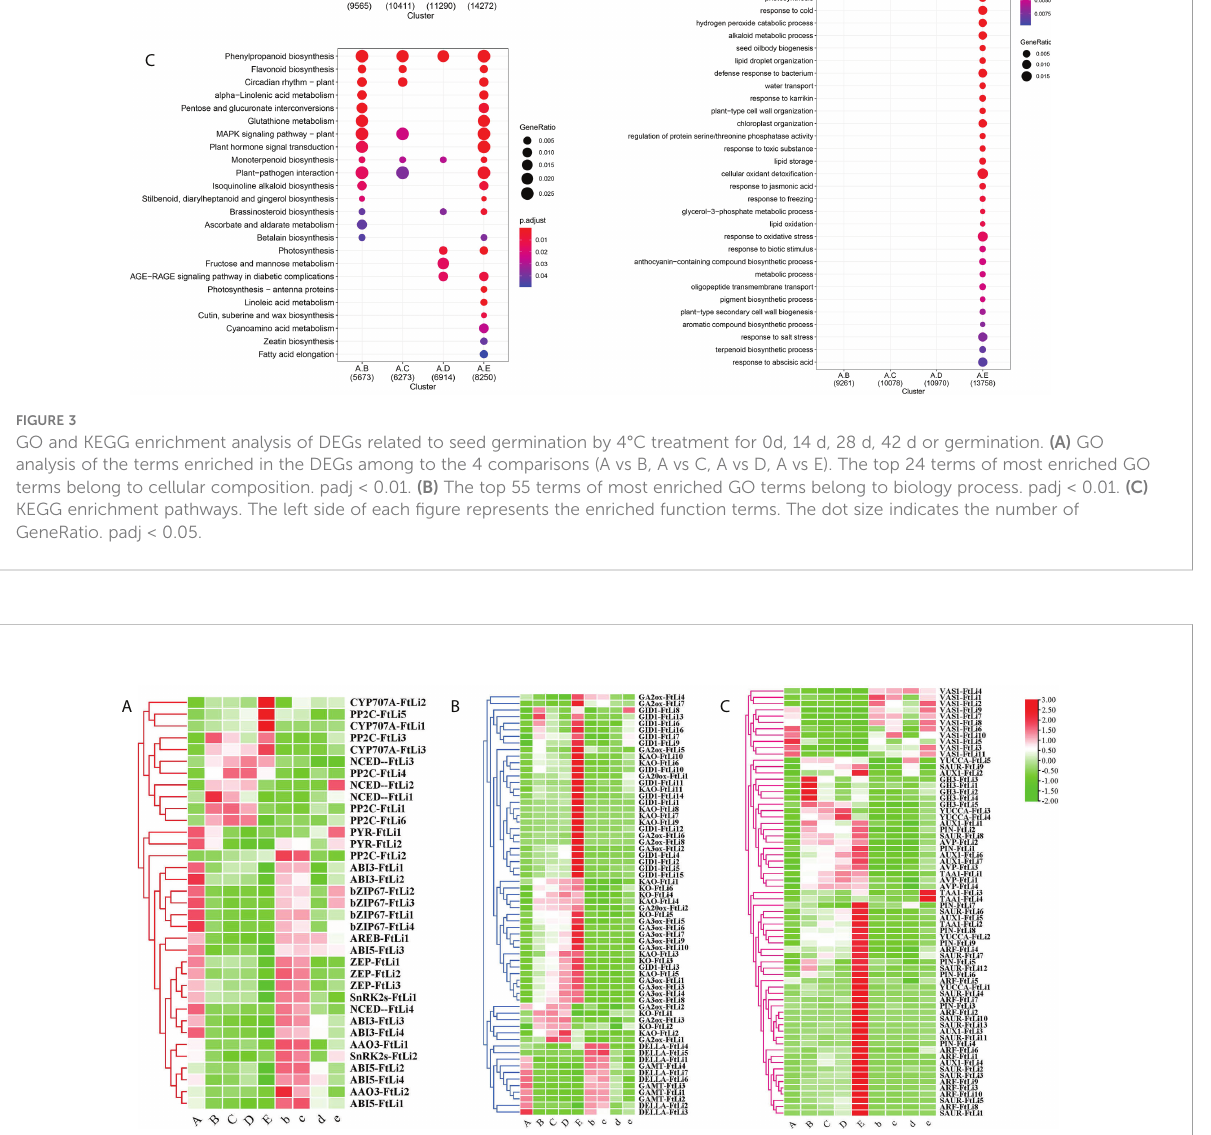
FIGURE 4 Heatmaps of the expression of ABA - (A) , GA- (B) , and auxin pathway (C) related genes between the treatments and controls. (A-E) represents the treatments and “ b ” , “ c ” , “ d ” “ e ” represents the controls, respectively. Red and green represent up- and downregulated transcripts, respectively. All genes are listed in detail in Supplementary Table